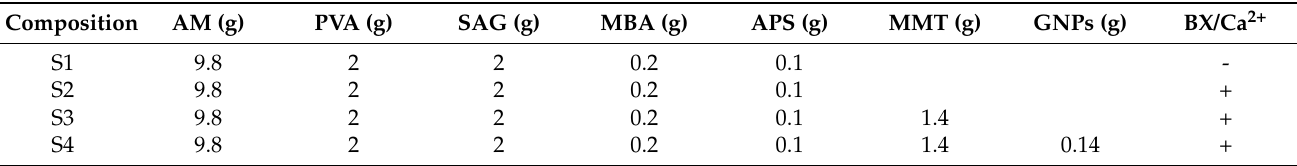
Table 1. Composition of the